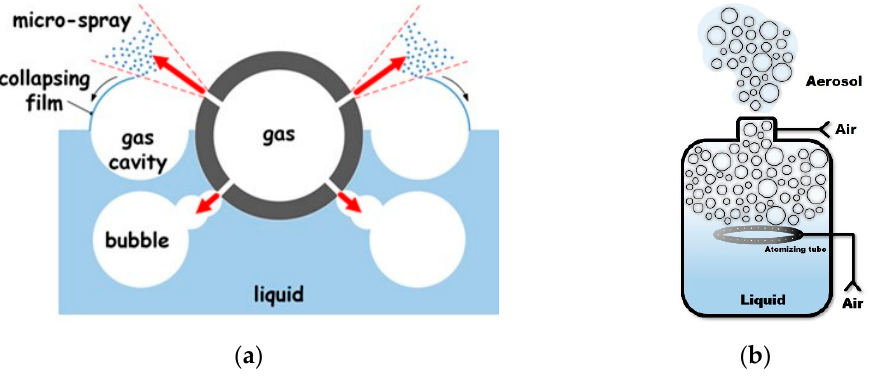
Figure 1. ( a ) Simultaneous production of bubbles, gas jets and micro-sprays of fine droplets in a cross- section of the atomizing tube [25] ; ( b ) schematic of novel aerosol